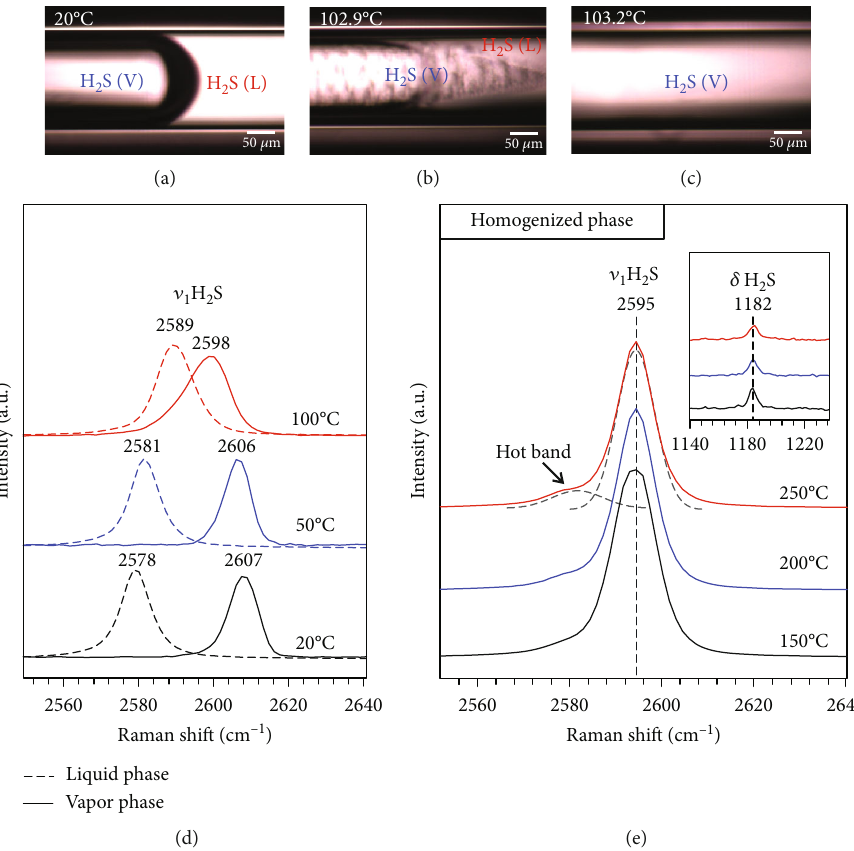
Figure 2: Phase behaviors (a – c) and in situ Raman spectra (d and e) of the pure H coexisted at 20 ° C, (b and c) the liquid – vapor phase boundary disappeared gradually and became a single fl uid phase at ~ 103.2 ° C, (d) in situ Raman spectra of the liquid and vapor phases at 20 – 100 ° C, and (e) in situ Raman spectra of the homogenized phase at 150 – 250 °